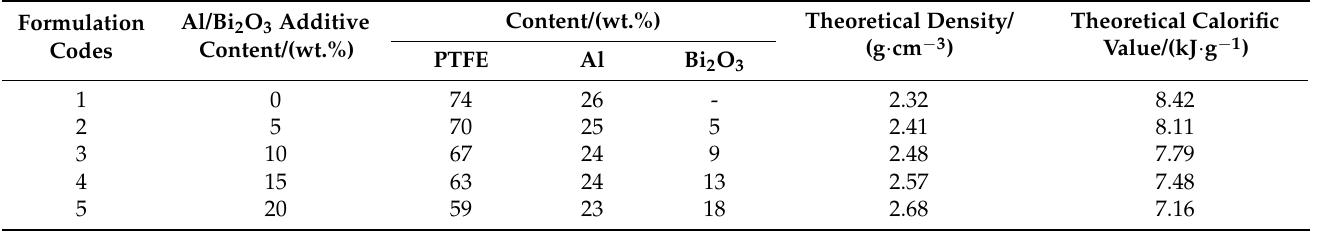
Table 1. Details of the formulation.